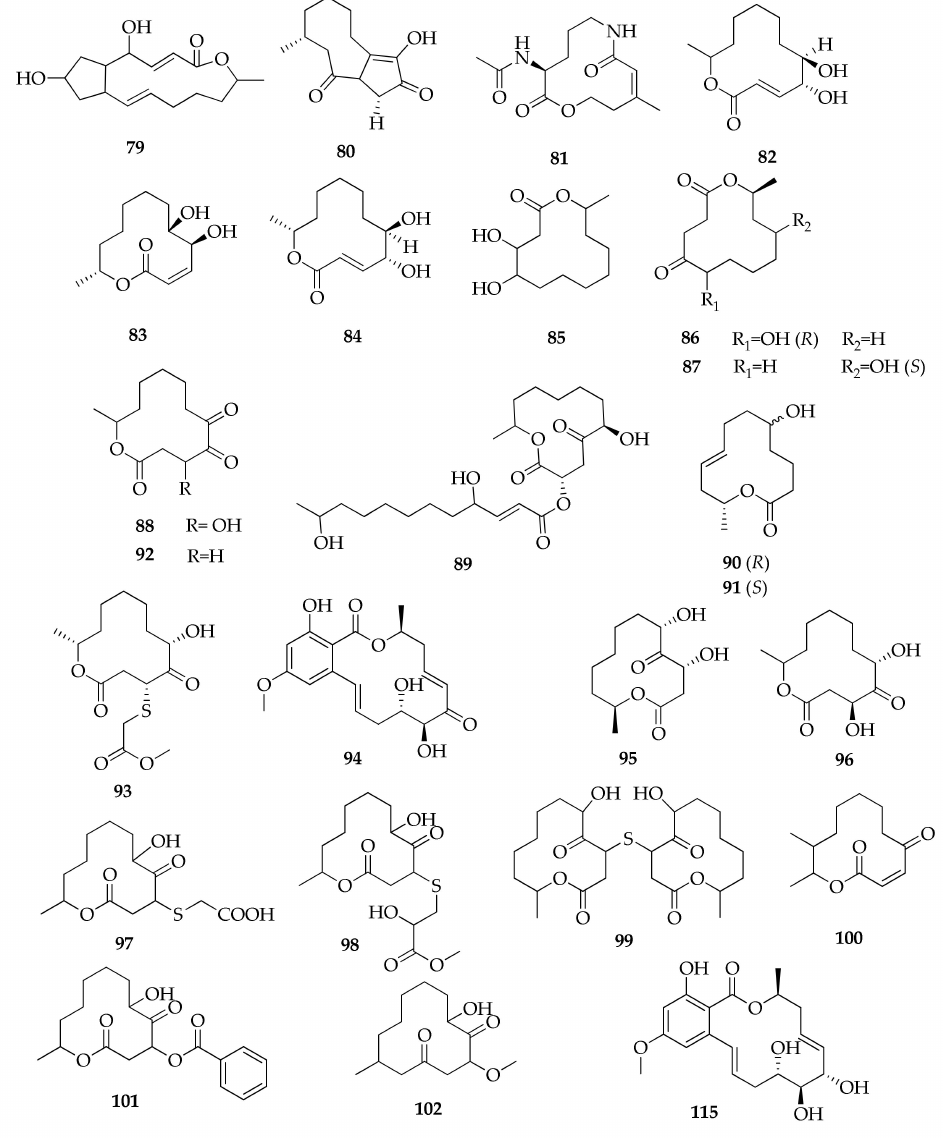
Figure 18. Structures of